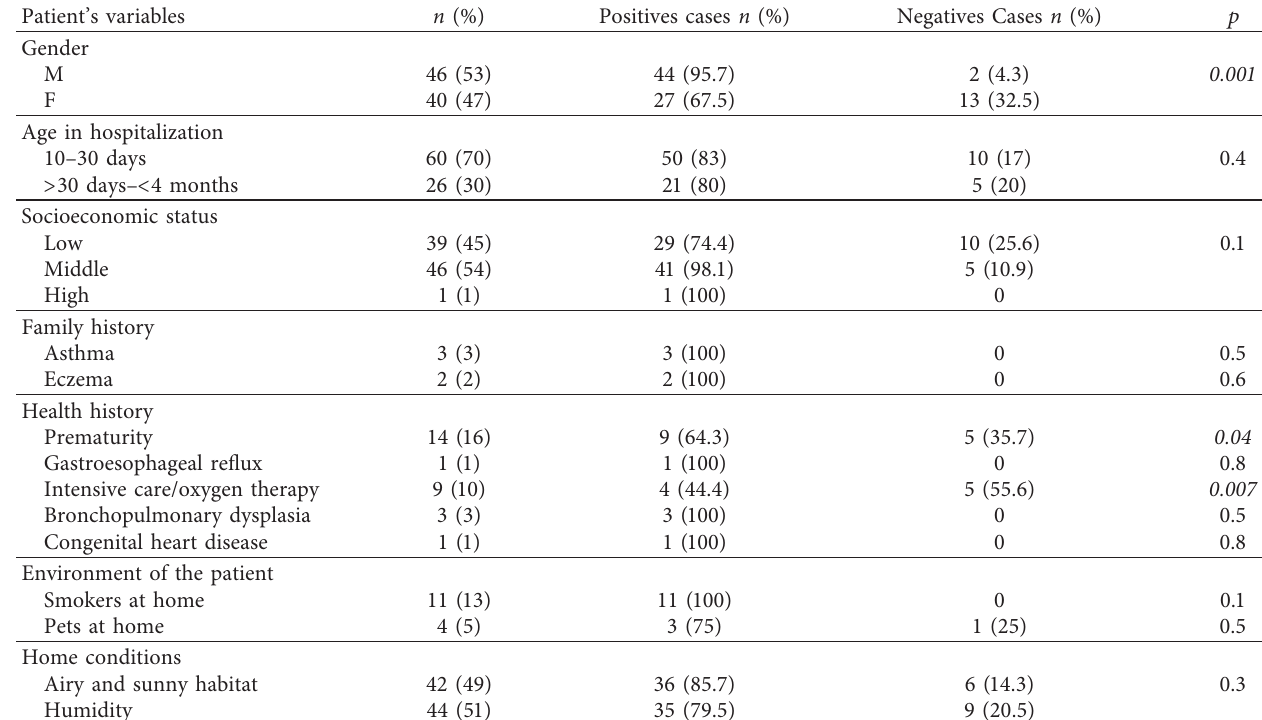
Table 1: General characteristics of the recruited patients (December 1, 2016, to May 31, 2018; N � 86). Patient’s